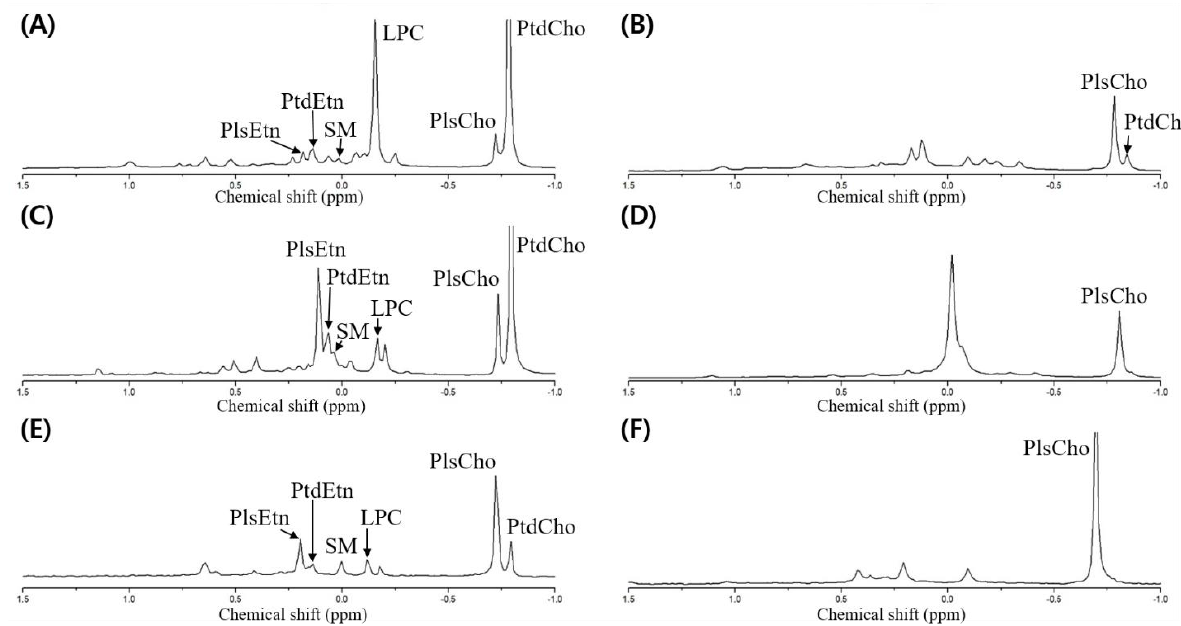
Figure 3. 31 P-NMR spectrum of phospholipid extracted from the dried opossum shrimp, mussel, and sea cucumber. ( A ) Dried opossum shrimp; ( B ) PLA 1 -pretreated dried opossum shrimp; ( C ) dried mussel; ( D ) PLA 1 -pretreated dried mussel; ( E ) dried sea cucumber; ( F ) PLA 1 -pretreated dried sea cucumber.